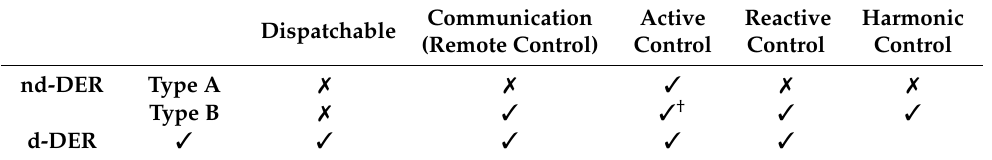
Table 1. Types of DERs considered for the MG and their control